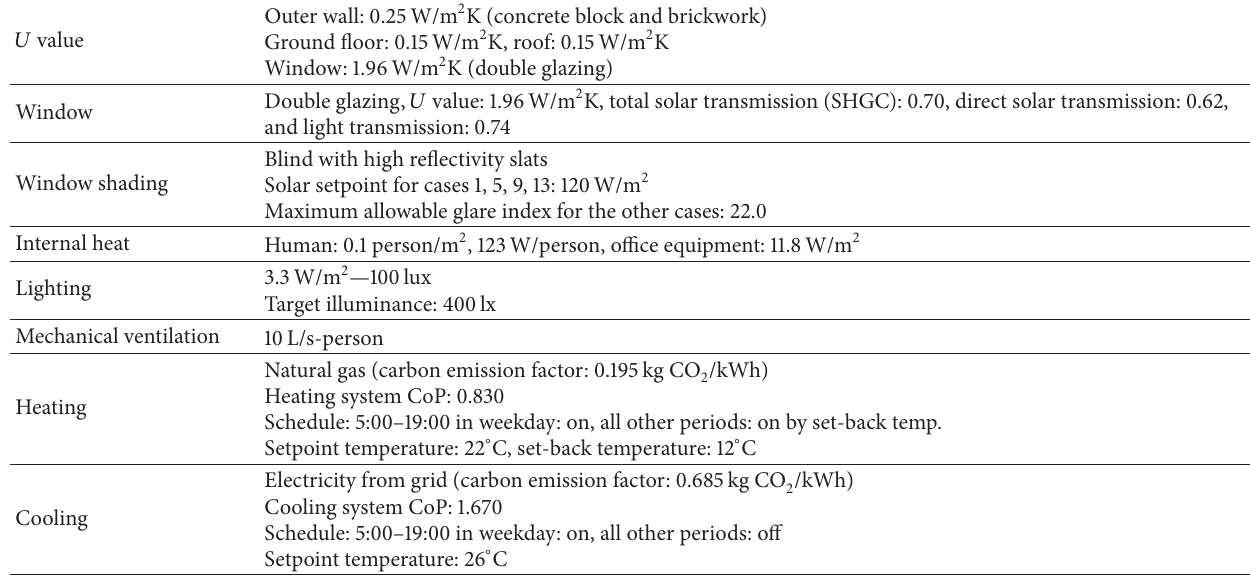
Table 2: Simulation